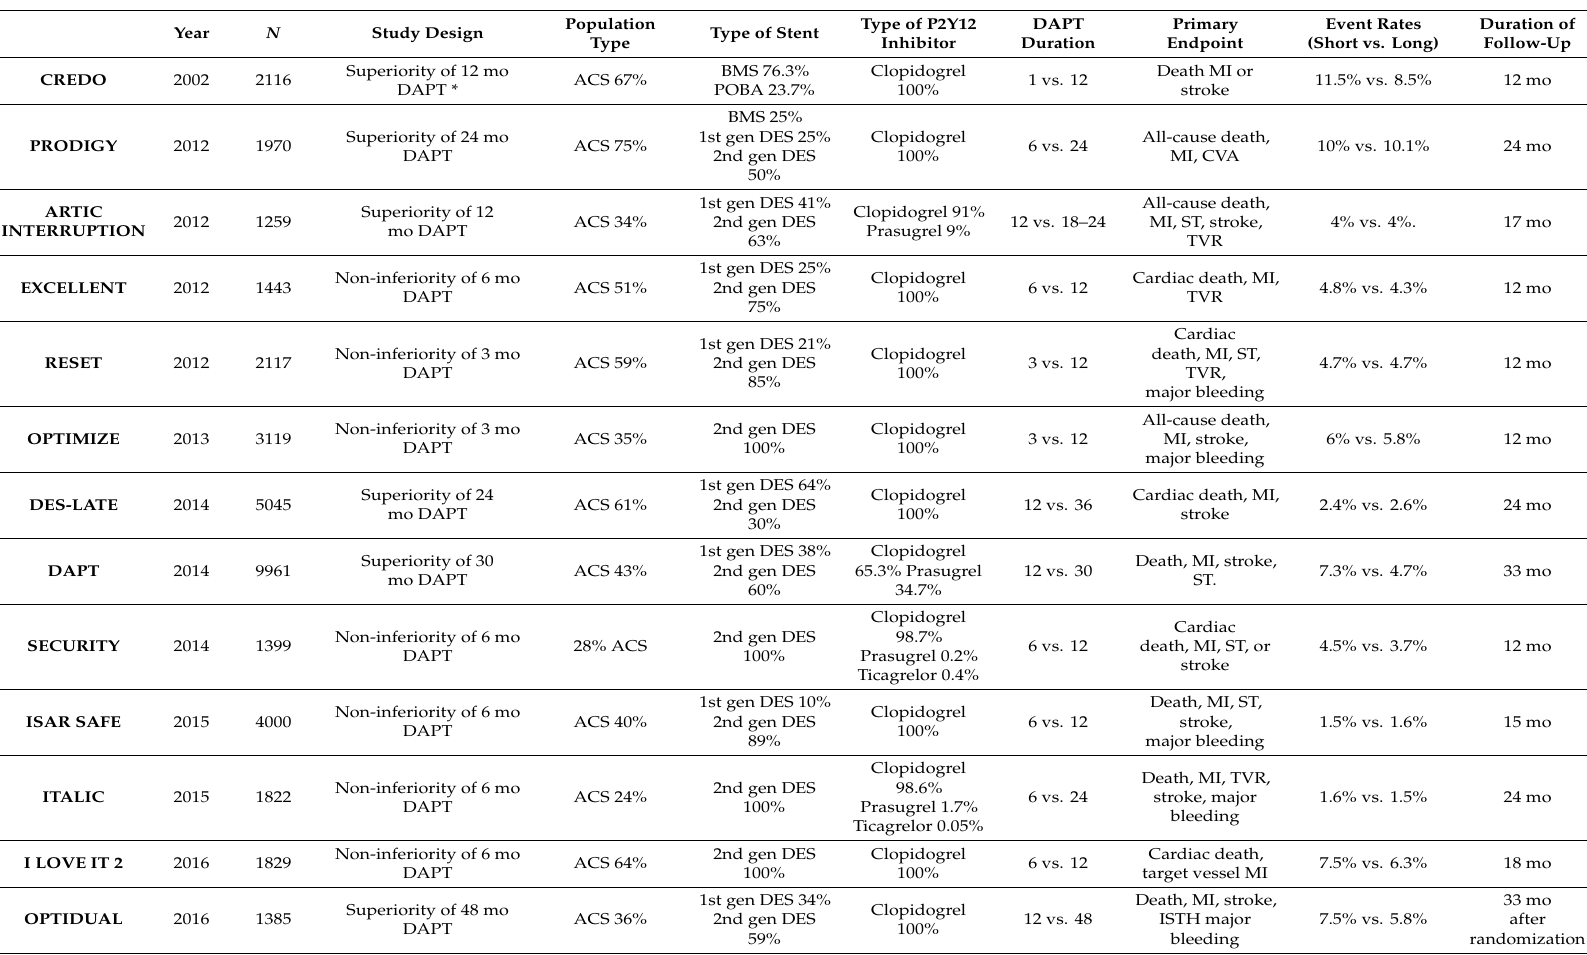
Table 1. Randomized controlled trials of dual antiplatelet therapy duration in patients treated with percutaneous coronary